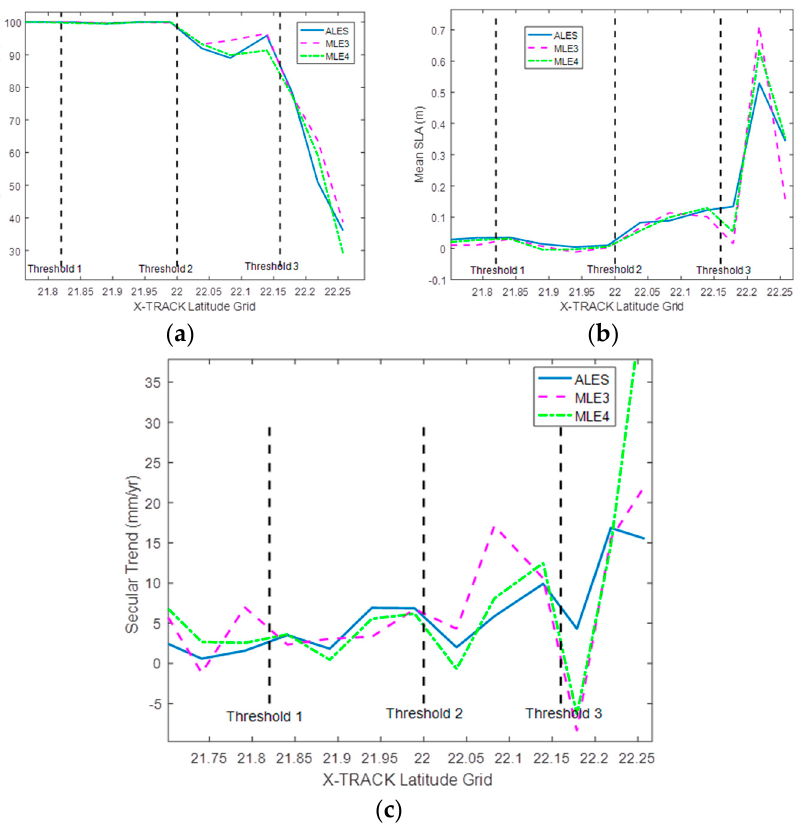
Figure 11. ( a ) Percentage of valid measurements; ( b , c ) mean values and 6.5-yr trend estimates for ALES, MLE3, and MLE4 retrackers. Results are presented as a function of latitude. The sea level residuals obtained after removing the trend and seasonal signal are shown in Figure 12 for MLE3, MLE4, ALES and the tide gauge data. A 3-month low pass filter was applied to the different SLA time series. For most cycles, the altimetry-based SLA have variations similar to the tide gauge, but the latter occasionally shows larger anomalies. In the first few cycles, the tide gauge residuals have surprising low values, and around cycle 135–160 have a few large negative peaks. Very local small-scale tides, waves, and currents may cause these sea level signals. The standard deviations of the altimetry SLA residuals with respect to the tide gauge residuals, before and after the 3-month smoothing, are given in Table 6. The improvement due to the smoothing is significant, the standard deviations decreasing by more than 50%. The consistency between the altimetry and tide gauge residuals is about 5 cm, which is encouraging given that the study area which is quite complex. ALES SLA has slightly larger standard deviation with respect to tide gauge sea level.